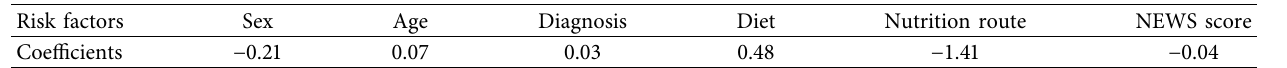
Table 5: Regression coefficients of HaM risk factors.